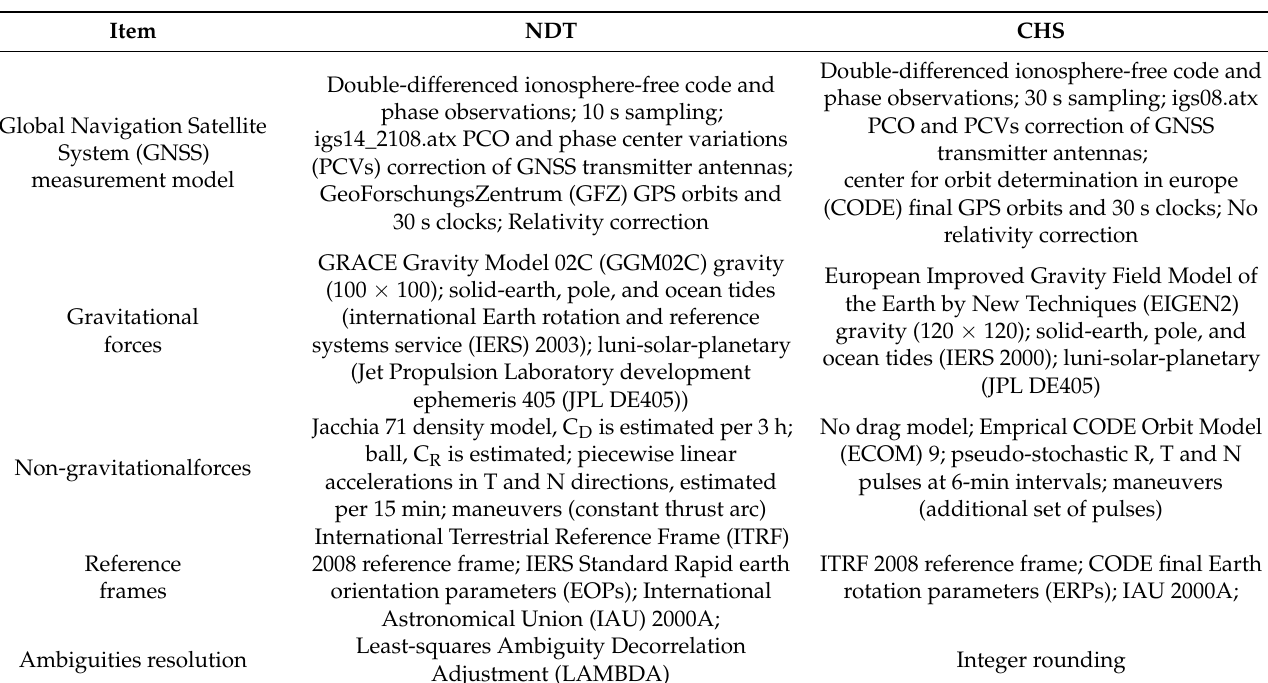
Table 2. Strategy of National University of Defense Technology (NDT) and Xi’an Research Institute of Surveying and Mapping (CHS) software packages for baseline